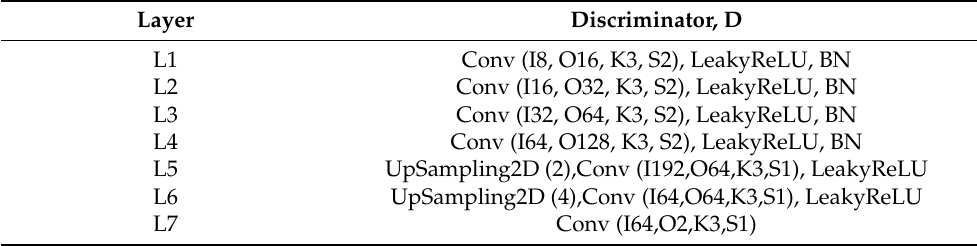
Table 2. Discriminator